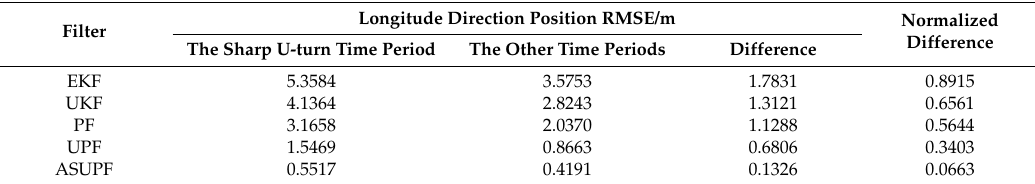
Table 5. Robust performances of EKF, UKF, PF, UPF and ASUPF.